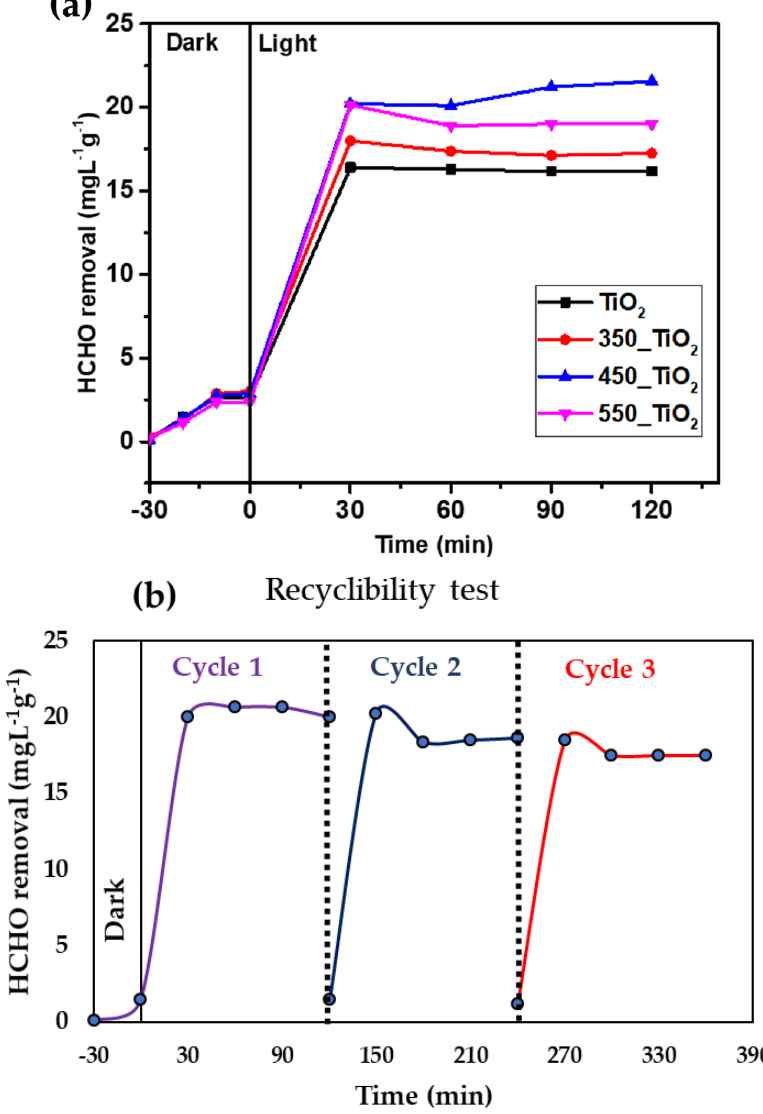
Figure 9. ( a ) E ff ect of calcination temperatures on the photodegradation of formaldehyde. Experimental Figure 9. ( a ) Effect of calcination temperatures on the photodegradation of formaldehyde. conditions: 3.22 ppm initial formaldehyde concentration, 25 ◦ C, 150 W, and ( b ) recycling results of Experimental conditions: 3.22 ppm initial formaldehyde concentration, 25 °C, 150 W, and ( b ) recycling 450_TiO 2 HCHO results of 450_TiO 2 HCHO removal.